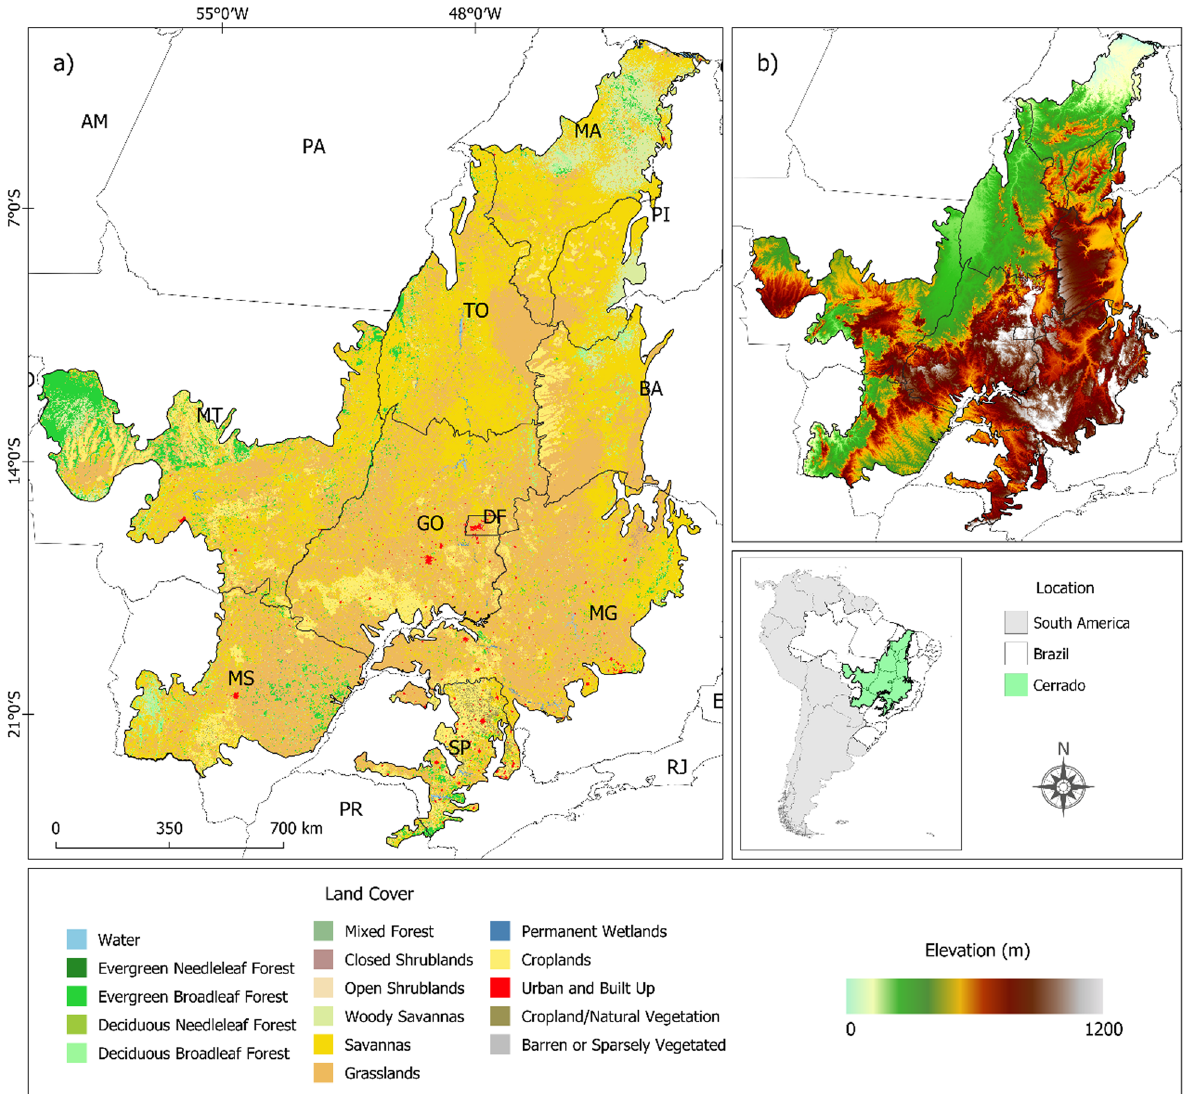
Fig. 1 Delimitation of the Cerrado biome, located in the central South America (middle right panel), classified into a 16 land use and land cover classes (top and bottom left side) (Bontemps et al. 2015, ESA 2021); and b elevation (top right panel, unit: meters) which spans from 0 to 1200 m (bottom right panel) (Jarvis et al.